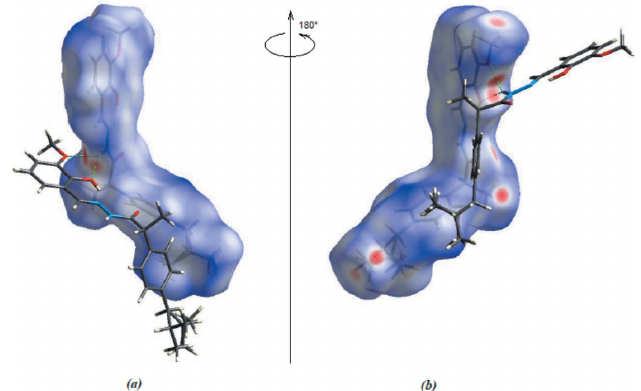
Figure 3 ( a ) Front view and ( b ) back view of the three-dimensional Hirshfeld surface of the title compound plotted over d norm in the range (cid:5) 0.3801 to +1.4738 a.u. The red, white and blue regions visible on the d norm surfaces indicate contacts with distances shorter, longer and equal to the van der Waals separations, respectively. The red spots highlight the interatomic contacts, including the O—H (cid:3)(cid:3)(cid:3) N and N—H (cid:3)(cid:3)(cid:3) O hydrogen